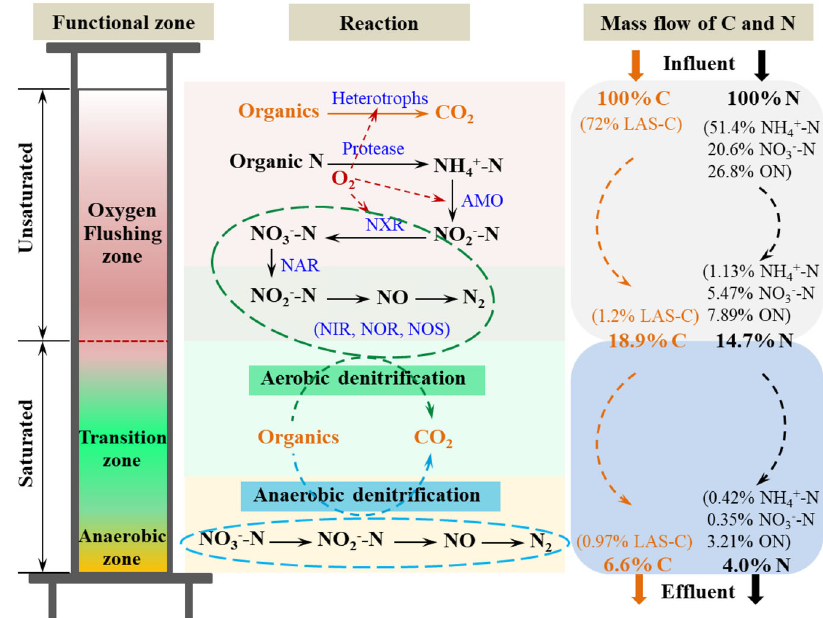
Fig. 6 Carbon and nitrogen mass fl ows and removal mechanisms. Functional zones, reactions responsible for organics and nitrogen removal, and the mass fl ow of carbon and nitrogen at different positions of the bio-enhanced granular-activated carbon dynamic bio fi lm reactor (BhGAC-DBfR) during graywater trearment. The data present in the mass fl ow panel was obtained from Phase